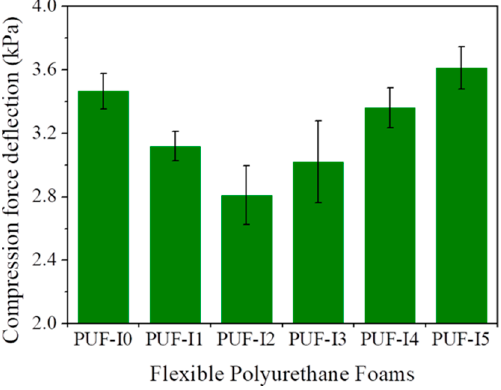
Figure 4. CFD of FPUFs with various ISB content.